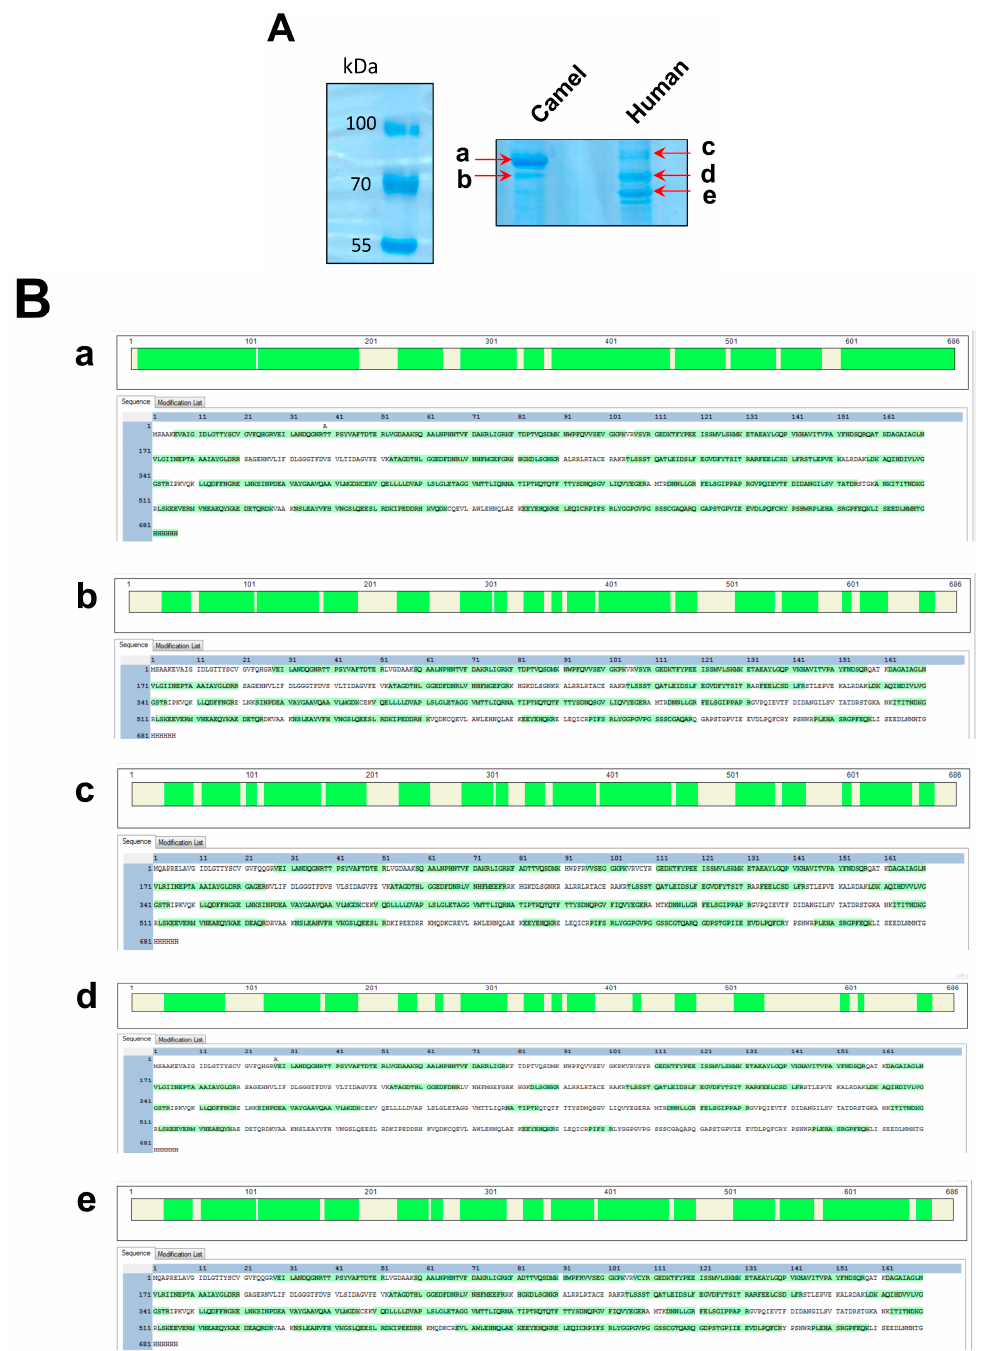
Figure A2. Expression and mass spectrometry analysis of camel and human HSPA6. ( A ) 9% SDS showing the expressed protein forms of recombinant camel HSPA6 (cHSPA6) and human HSPA6 (hHSPA6) after transfection of COS-1 cells and IP using anti-Myc antibody. The cHSPA6 revealed 2 isoforms ( a , b ) while hHSPA6 showed 3 isoforms ( c – e ); ( B ) Mass Spectrometry results of the excised cHSPA6 and hHSPA6 protein bands. The green coloration indicates the coverage of the analyzed peptides.